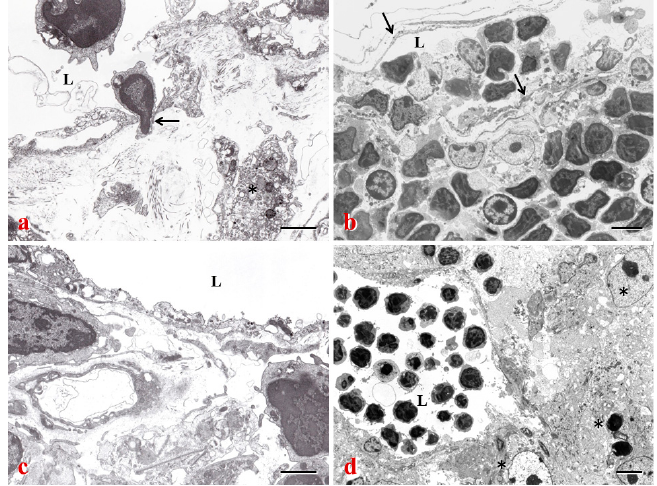
Figure 4. Peripheral lymphatic vessels ( a ) and intranodal lymphatic sinuses ( b – d ) in mouse tissues. ( a ) In the non-obese diabetic (NOD) pancreas, a lymphocyte is penetrating the lymphatic vessel stained with 5 ′ -Nase cerium (arrow). The asterisk indicates a macrophage; ( b ) In the LN of Bagg albino/c (BALB/c) mice, the subcapsular sinus is filled with lymphocytes and DCs. The arrows indicate endothelial layers of the lymphatic sinus; ( c ) The medullary sinus of NOD mice is decorated with 5 ′ -Nase cerium particles, and metabolic products of inflamed cells are seen beneath the endothelial layer; ( d ) The cortical sinus filled with lymphocytes is surrounded by metastatic melanoma cells (asterisks). L: lymphatic vessels or sinuses. Bars: ( a , c ) 2 μ m; ( b , d ) 5 μ m.